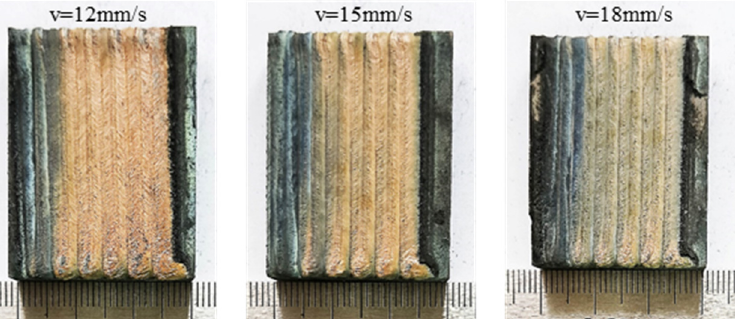
Figure 1. Surface morphologies of the coating under different laser scanning speeds.